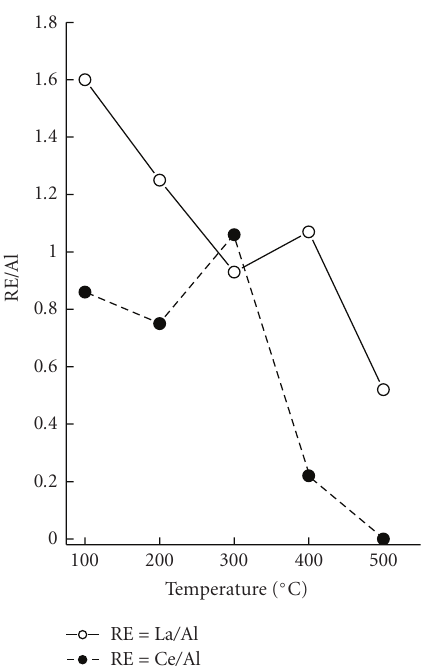
Figure 8: Variation of La/Al and Ce/Al ratios with temperature for the treated